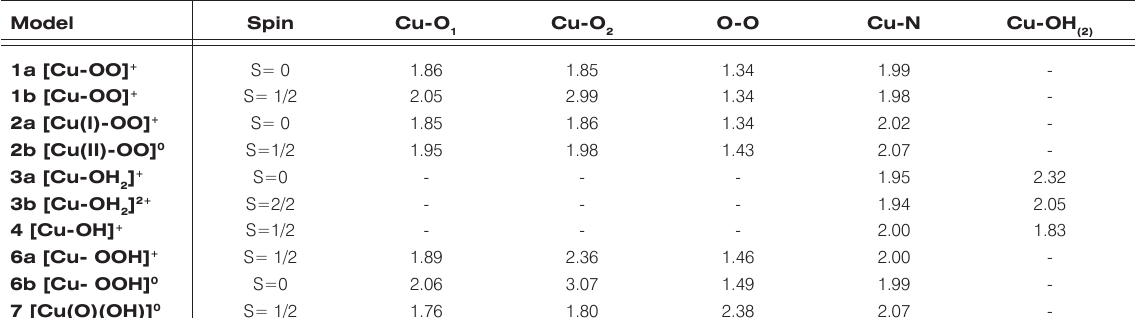
Table 2. Natural Atomic Orbital Populations at the copper for the models employed in the present study. Evidenced in grey are orbitals with populations distinctly smaller than 1.